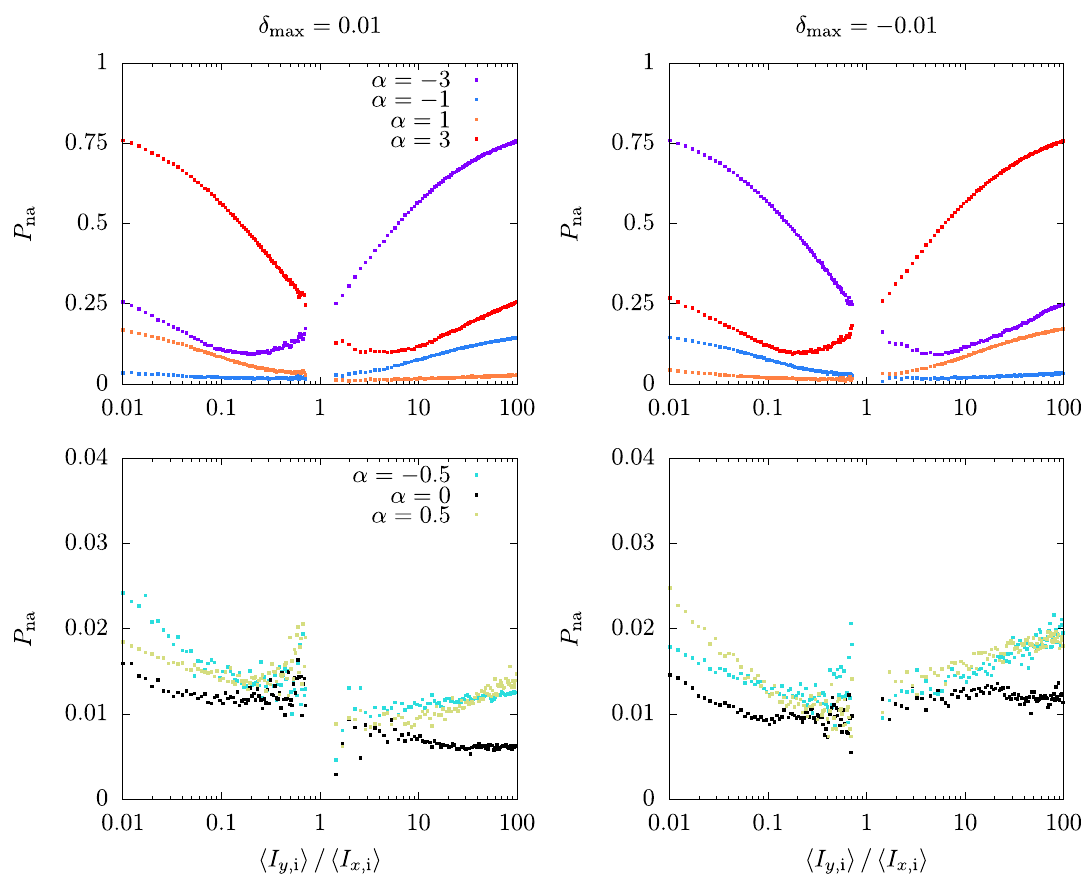
= h I α representing all the as a function of the initial emittance ratio h I y; x; i i , for seven values of na i i with different signs (left and right plots). Note the different max ≈ h I 5 = 7 ≤ h I = h I ≤ 7 = 5 have diverges when h I x; y; i i , data in the range y; i i x; i i na i i